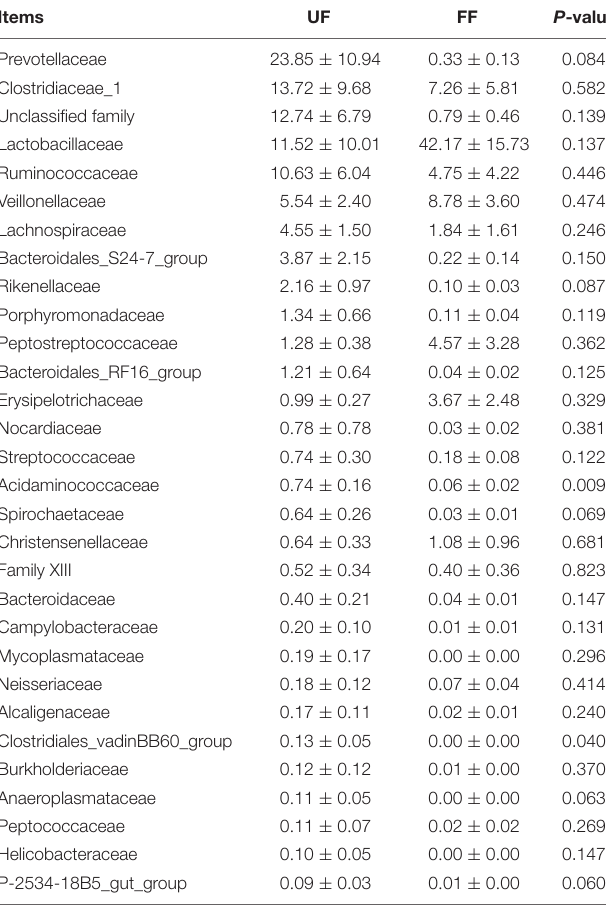
TABLE 7 | Relative abundance (percentage) for the top 30 most abundant family in the duodenum of pigs in the fermented feed (FF) and control (UF) groups. Items UF FF P -value